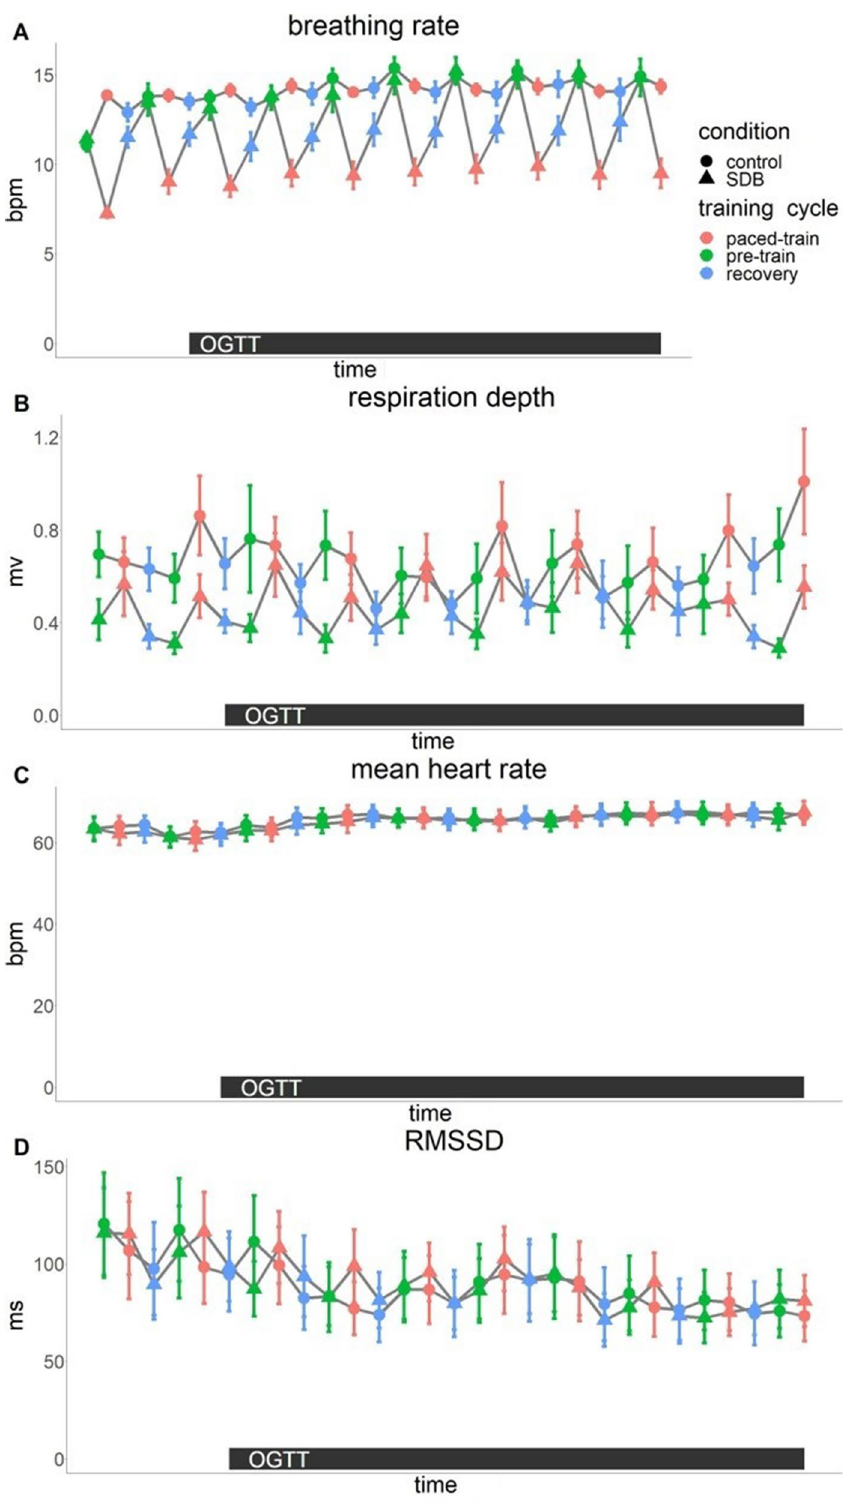
Figure 1. Breathing rate ( A ) and respiration depth ( B ), mean heart rate ( C ) and root mean square of successive differences (RMSSD, D ). Breathing rate was significantly lower during paced-train compared to pre-train in the slow deep breathing (SDB) condition (p < 0.0005) but not in the control condition (not significant, NS). Respiration depth (averaged by each participant and each condition) was significantly higher during paced-train compared to pre-train in both control and SDB conditions, and the differences between conditions were significant. Mean heart rate (averaged by each participant and each condition) was not significantly different between paced-train and pre-train in either condition. RMSSD increased significantly during paced-train compared to pre-train in SDB condition, but not in control condition, and the differences between the two conditions were significant. OGTT=oral glucose tolerance test; bpm=breaths per minute (A) or beats per minute (C); mv=millivolt;